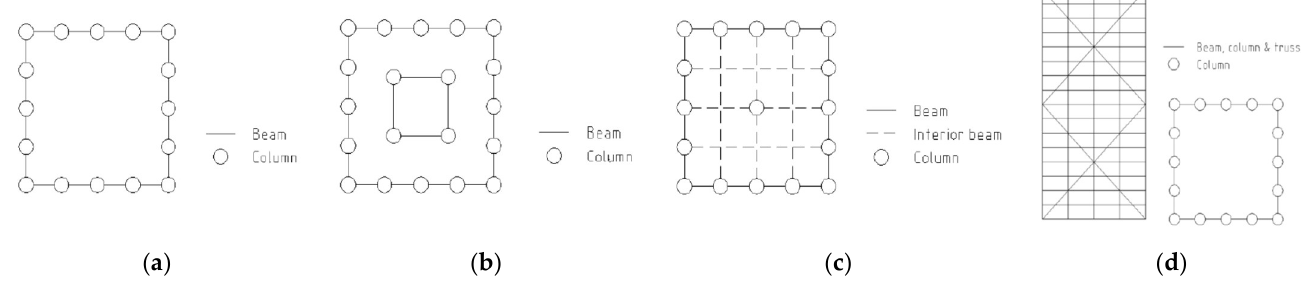
Figure 3. ( a ) Plan view of a framed-tube system, ( b ) plan view of tube-in-tube system, ( c ) plan view of bundled/modular tube system, ( d ) plan and side view of braced tube system. Source: